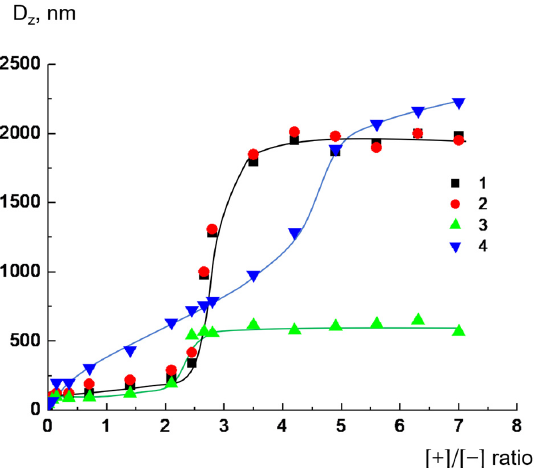
Figure 3. Hydrodynamic diameters of dendrimer–liposome complexes versus ratios of ionic groups [+]/[ − ] for D 350+ (1), D 229+ (2), D 215+ (3), and D 16+ (4), where [+] is the molar concentration of the pyridinium groups of dendrimers, and [ − ] is the molar concentration of negatively charged cardiolipin headgroups. CL/Chol/DOPCliposomes, [CL] = 1.5 × 10 − 4 mol/L, total lipid concentration of 1 mg/mL. 10 − 3 M phosphate buffer, pH 7.2.